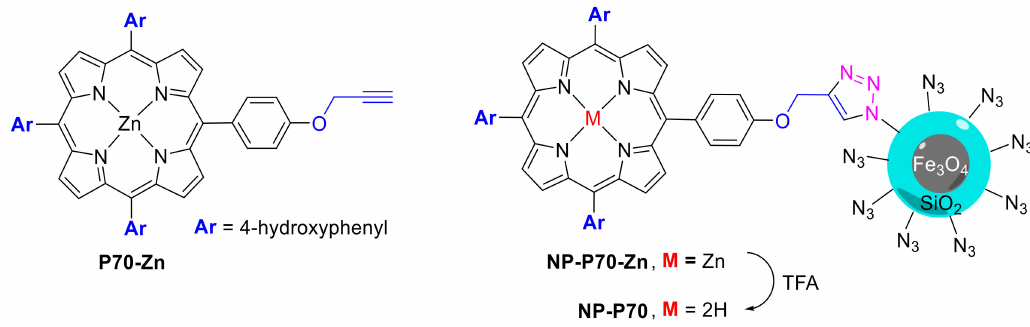
Figure 8. Magnetic nanoparticle NP-P70 prepared via click approach from porphyrin P70-Zn